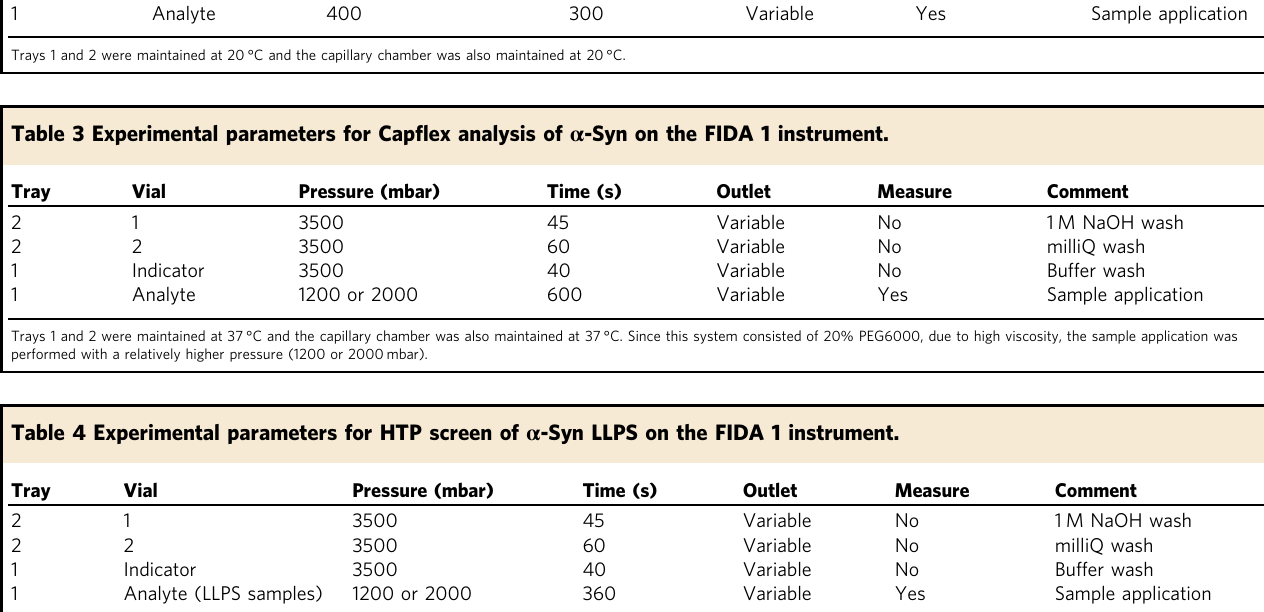
The following set of experimental parameters was used for all samples (Table 3): To note, the experimental parameters for the HTP screening of α -Syn LLPS is provided in Table 4.